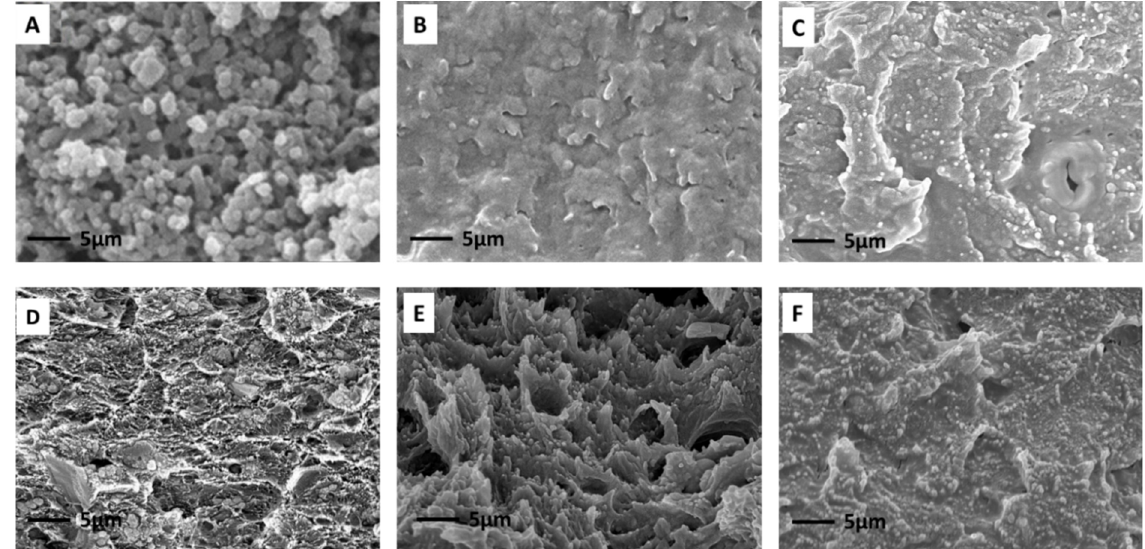
Figure 5. FESEM cross-section images of ( A ) pure NH 2 -ZIF-8, ( B ) CTA/CDA-0 wt.% NH 2 -ZIF-8, ( C ) CTA/CA-5 wt.% NH 2 -ZIF-8, ( D ) CTA/CDA-10 wt.% NH 2 -ZIF-8, ( E ) CTA/CDA-15 wt.% NH 2 -ZIF-8, and ( F ) CTA/CDA-20 wt.% NH 2